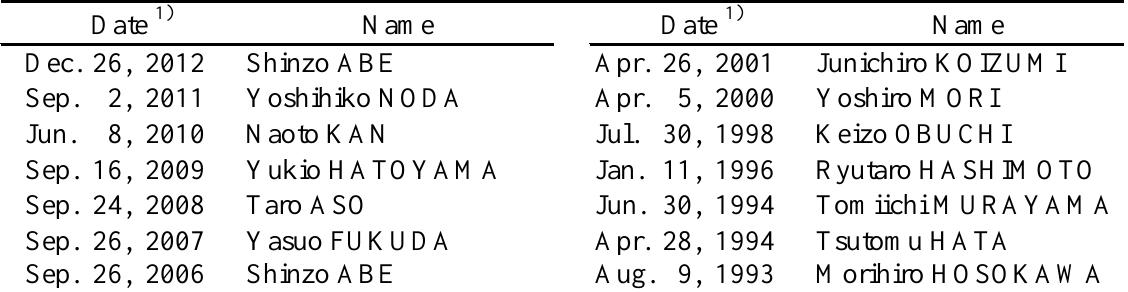
Successive Prime